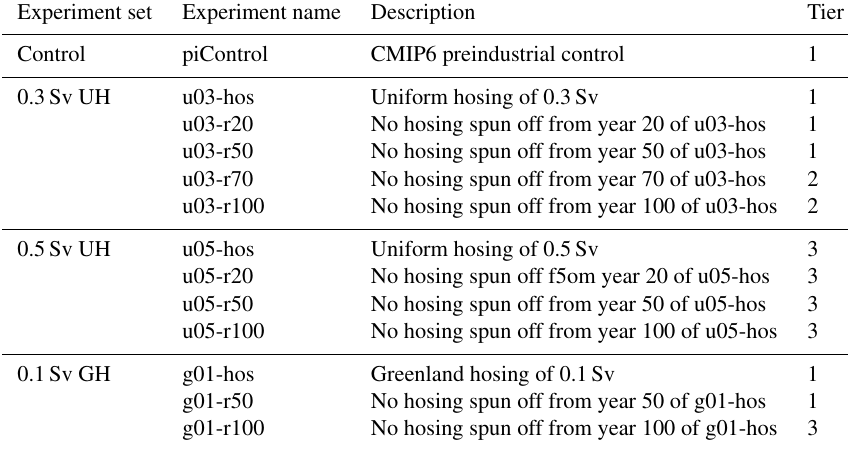
Table 1. Experiments.